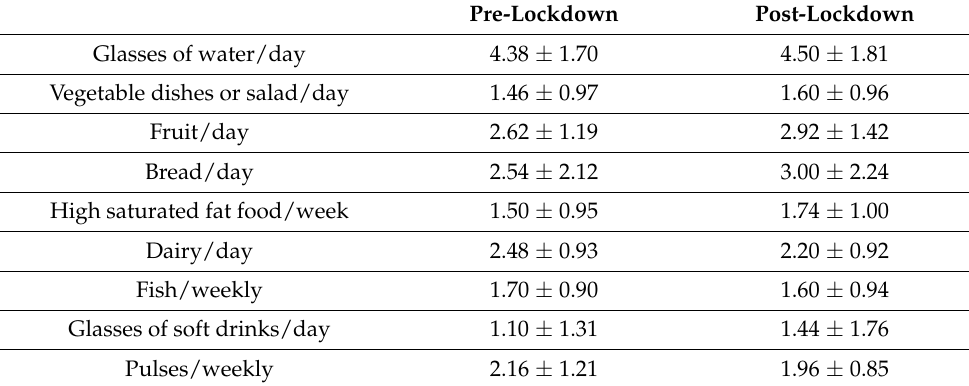
Table 5. Results of changes in feeding habits pre-lockdown and